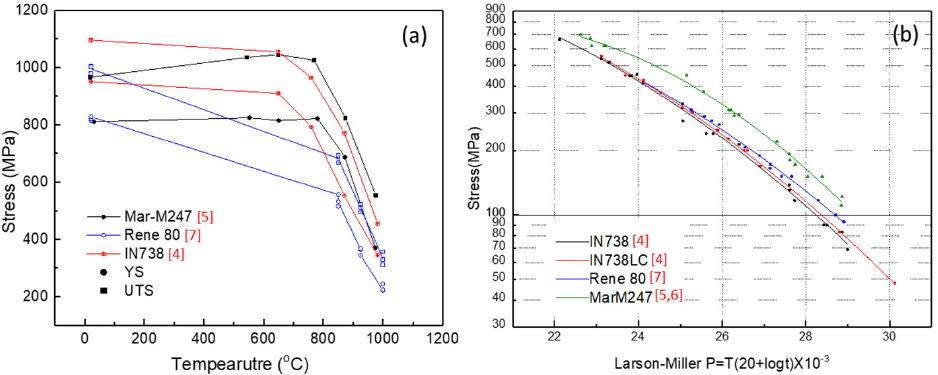
Figure 1. Mechanical properties of conventional cast superalloys, ( a ) strength, ( b ) Larson-Miller plot [4–7].